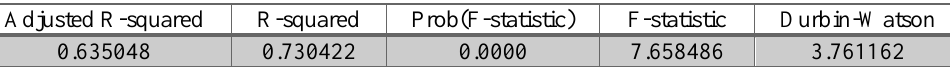
Table 8 . Other results of fixed effects- Model Number